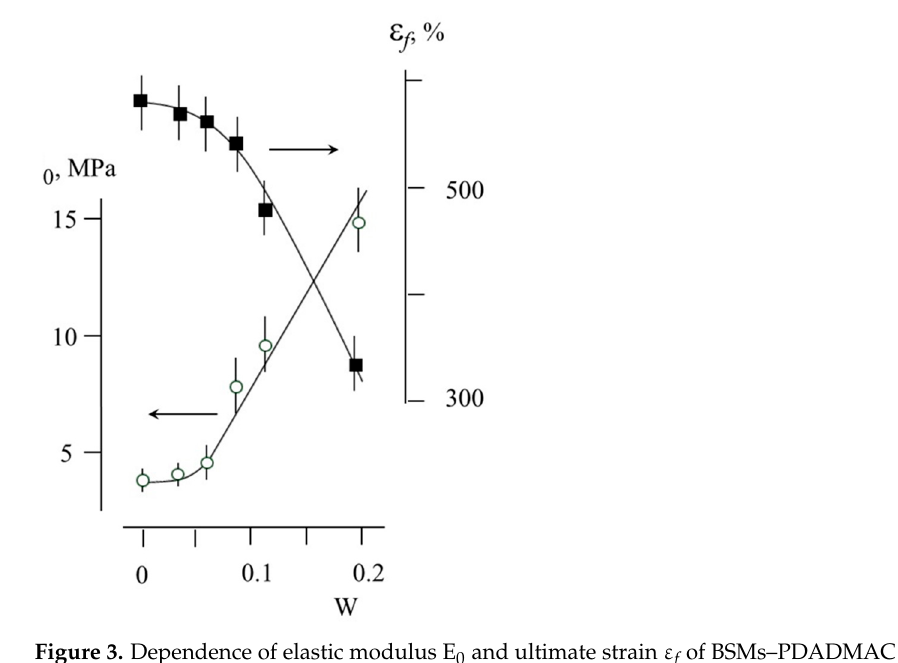
Figure 3. Dependence of elastic modulus E 0 and ultimate strain ε f of BSMs–PDADMAC films on the weight fraction of PDADMAC in formulation W.